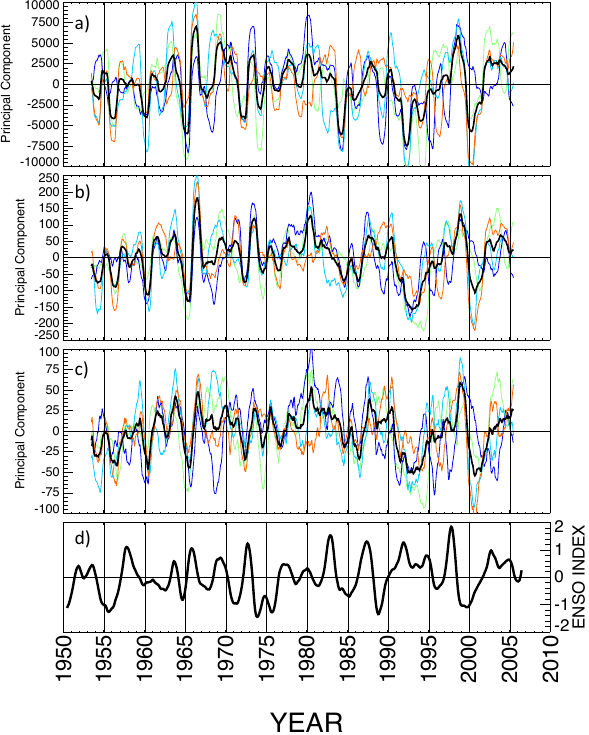
Figure 13. Timeseries of the principal component for the first EOF of ozone from 30–90 ◦ N for each ensemble simulation (color) and for the ensemble mean (black) at (a) 150hPa, (b) 500hPa and (c) the surface. The Ocean Nino Index (ONI) based on sea surface tem- perature anomalies in the Niño 3.4 region is given in the lower